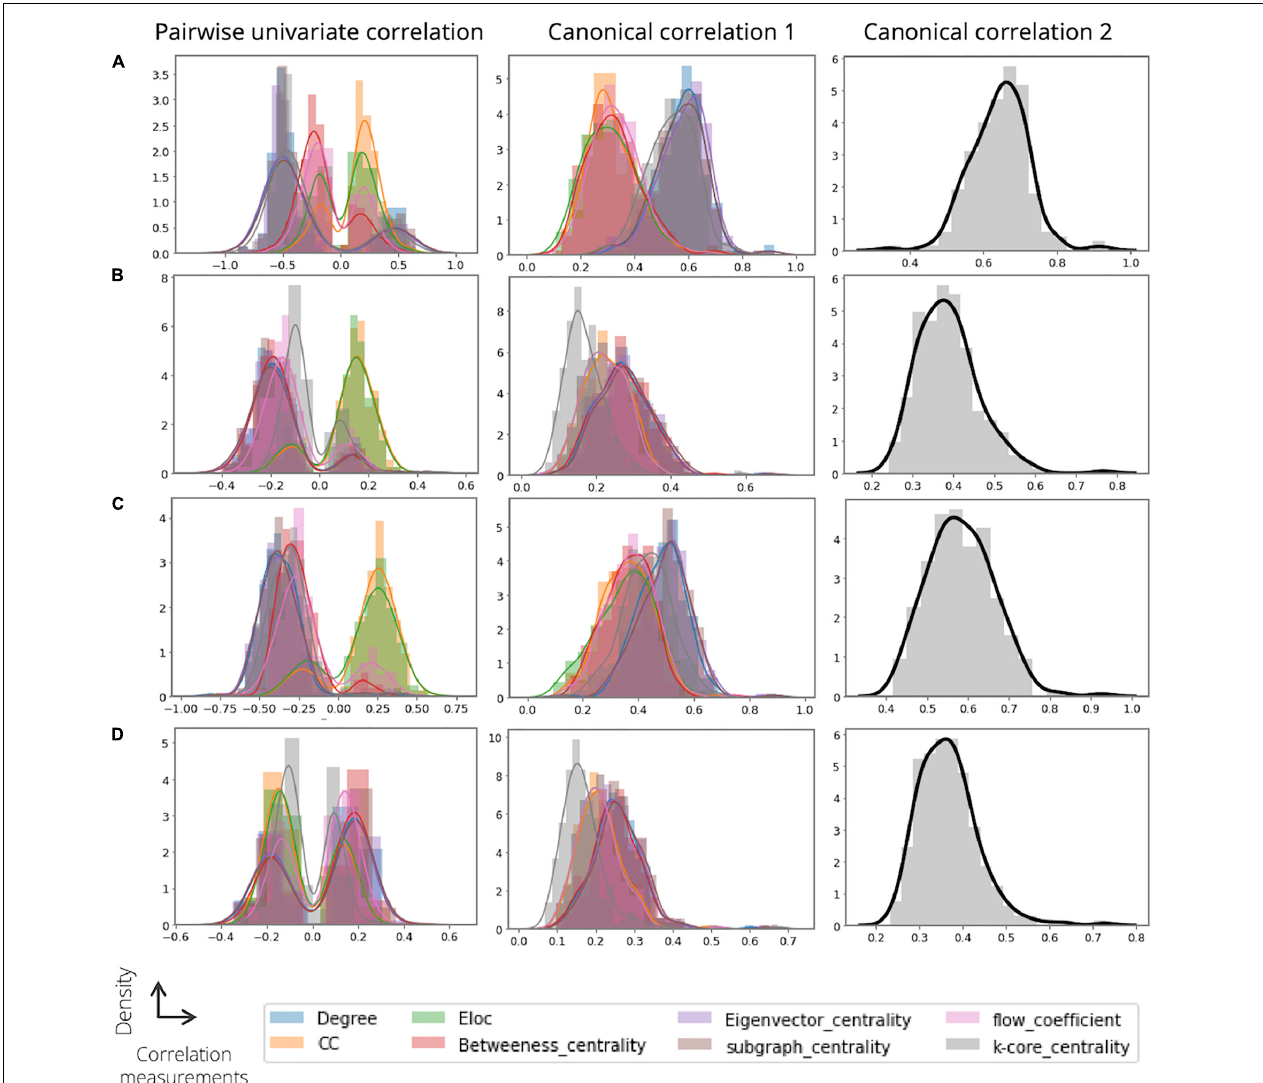
FIGURE 4 | Results of analysis on investigating the relationship between the extracted features (domain 1) and graph theory-based nodal measurements (domain 2). For each analysis, we obtain and show the distribution of the correlations for (A) ASD severity score, (B) ADI RRB, (C) ADI verbal, and (D) ADI social. In the distribution plot, x-axis and y-axis indicate the correlation value and corresponding density,